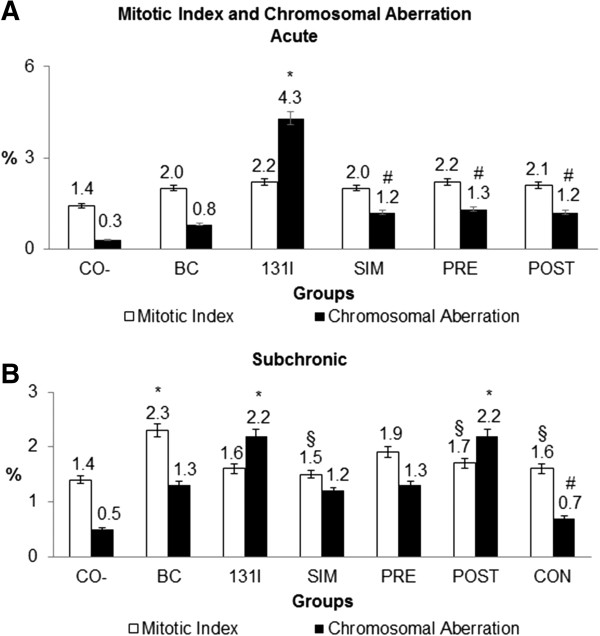
Percentage and standard deviation of mitotic index and chromosomal aberration of different antimutagenic treatments in acute (A - 24 hours) and subchronic (B - 5 days) groups. Groups: Negative control: CO-; Barbados Cherry: BC (Results published in [14]); Iodine-131: 131I (Results published in [5]). Antimutagenic Treatments: SIM: simultaneous; PRE: pre-treatment; POST: post-treatment; CON: continuous. * Statistically significant result compared with negative control (p < 0.01). # Statistically significant result compared with treatment with 131I (p < 0.04). § Statistically significant result compared with treatment with BC (p < 0.02).